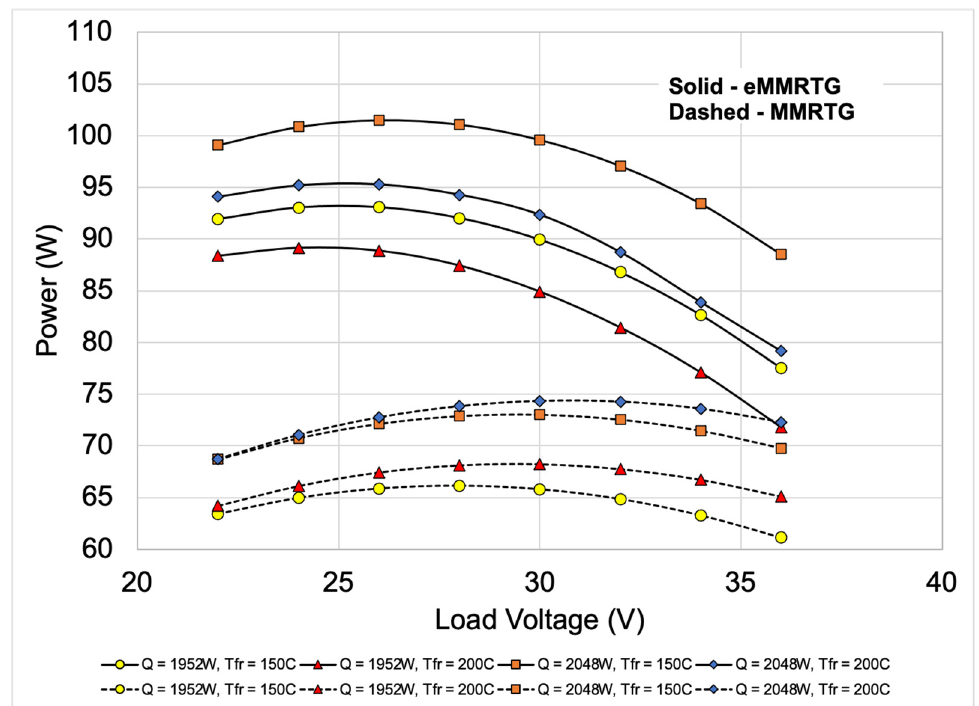
Figure 13. Comparison of current-best-estimate eMMRTG and MMRTG 17-year power output prediction as a function of beginning-of-life fuel inventory (Q), generator fin root temperature (Tfr), and load voltage (V). The prediction assumes 3 years of storage followed by 14 years of operation.